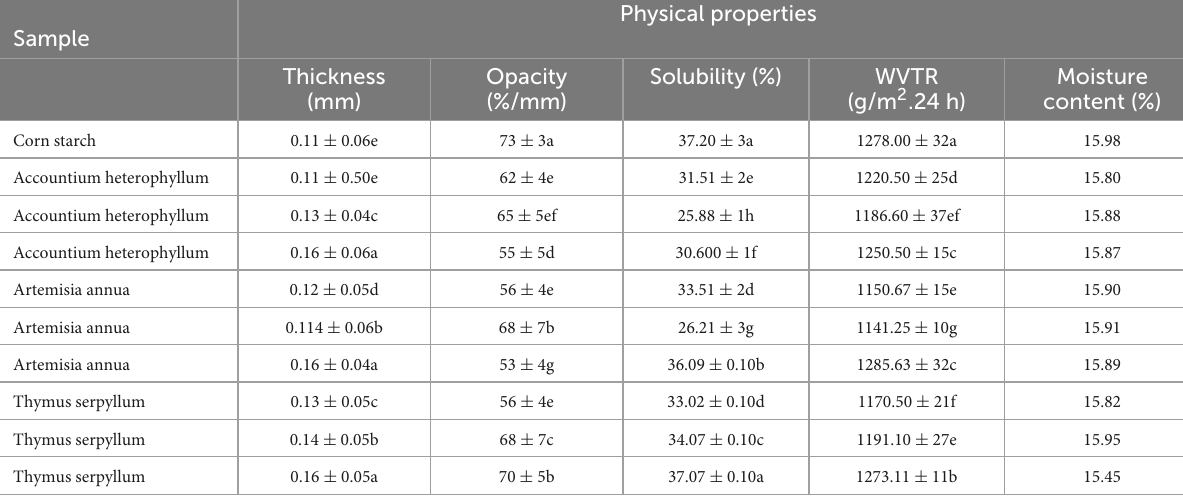
TABLE 2 Effect of starch based films reinforced with different medicinal plants on physical properties of films.